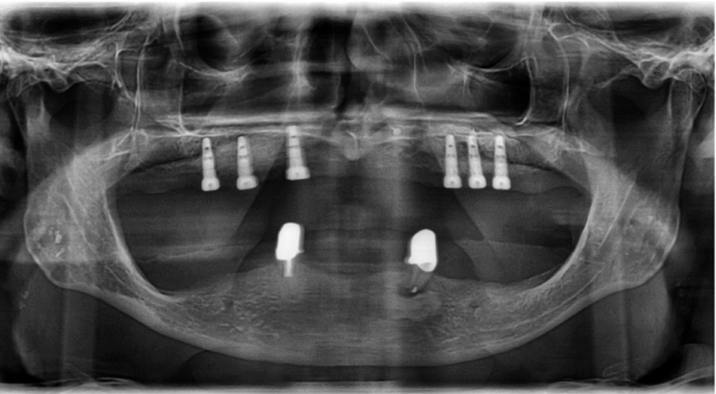
Figure 1. Panoramic tomography of the first case vignette. In the lower jaw, the remaining teeth 33 and 43 are present. Tooth 33 shows apical periodontitis. There is a bony height deficit in the premolar and molar areas of the lower jaw.